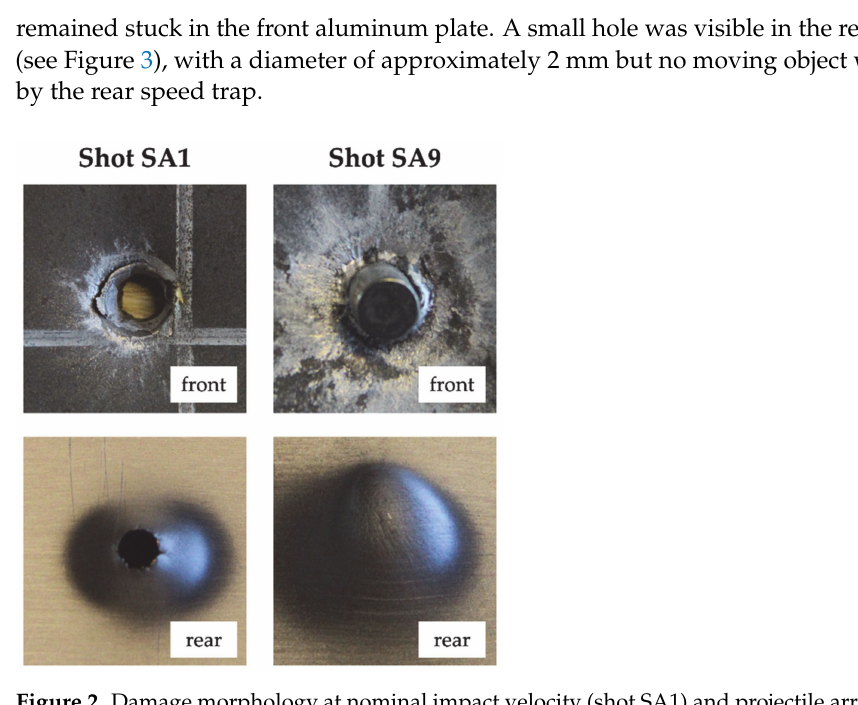
Figure 2. Damage morphology at nominal impact velocity (shot SA1) and projectile arrest (shot SA9).